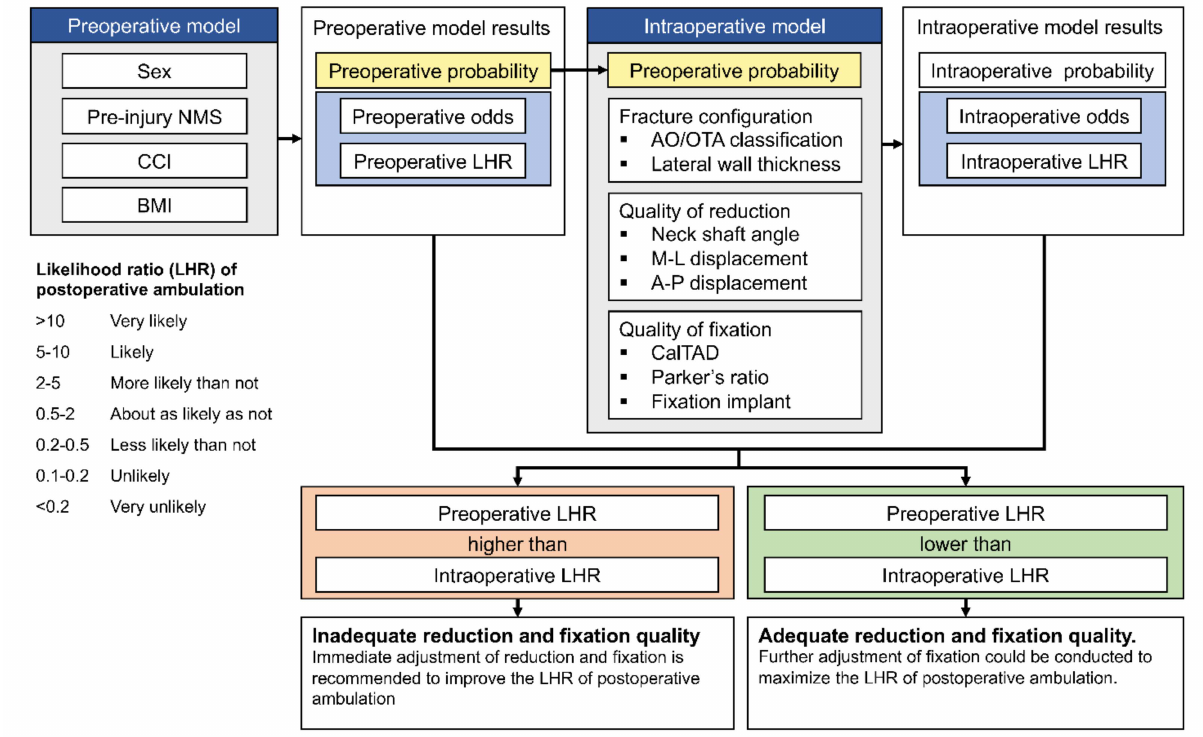
Figure 1. An infographic of the intertrochanteric fracture ambulatory prediction (IT–AP) tool. A preoperative model was modeled using the patient’s pre-injury demographic information, for which preoperative probability, odds, and likelihood ratio of postoperative functional outcome will be provided. After incorporating surgical-related parameters and the preoperative probability into an intraoperative model, an intraoperative prediction will be calculated and reported. A recommen- dation regarding the result provided by both preoperative and intraoperative prediction models will be given. NMS, New Mobility Score; CCI, Charlson comorbidity index; BMI, body mass in- dex; LHR, likelihood ratio; M–L, medio-lateral; A–P, antero-posterior; CalTAD, calcar-referenced tip-apex